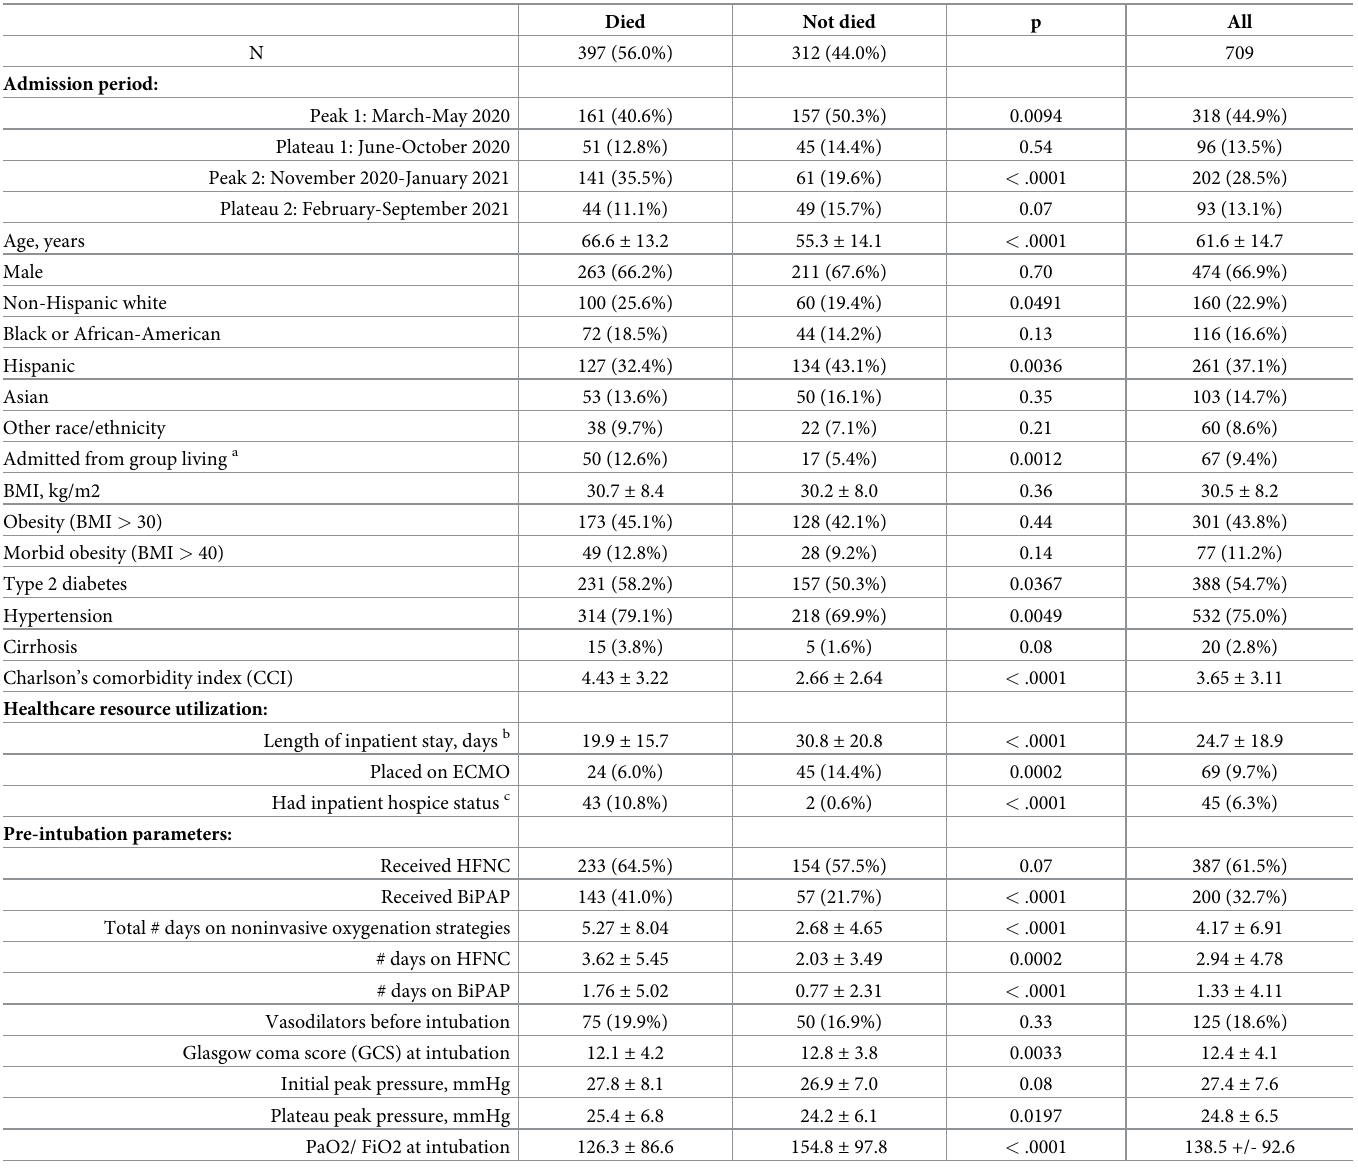
Table 1. Comparison of patients who died vs. not died on mechanical